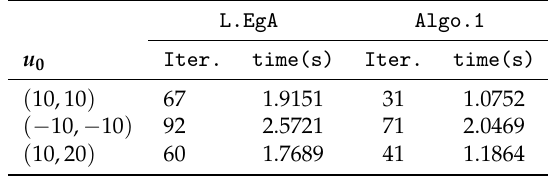
Figure 15. Example 4 while u 0 = ( 10,20 ) . Table 6. Figures 13–15 numerical